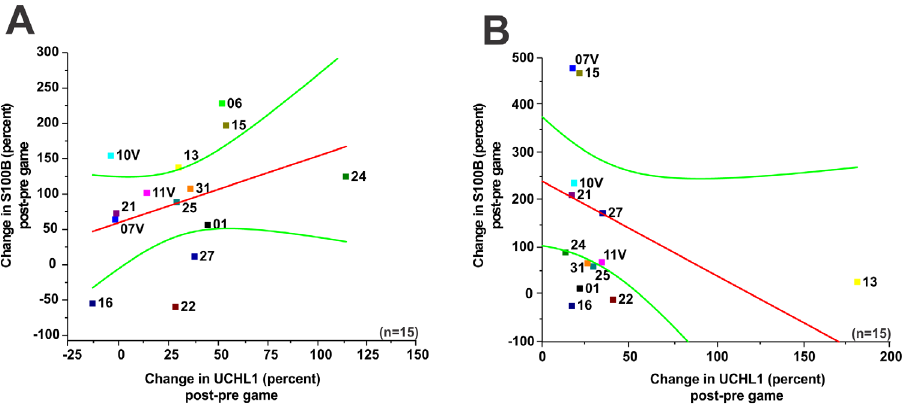
Figure 4. Markers’ change following a game confirms lack of correlation between S100B and UCH-L1. A–B ) refers to normalized serum surges of S100B and UCH-L1 after game 1 and game 2. Note lack of correlation between these markers ( p =0.19; R 2 =0.37; game 1, p =0.11; R 2 = 2 0.45; game 2). The red line is the linear regression fit while the outer lines show confidence intervals of 95%. We measured the normalized percent change in each game in an attempt to correct for the possibility of different measuring sensitivities for subconcussive head hits for the two markers measured by ELISA. Significance is determined by ANOVA and denoted as (*) for p , 0.05.